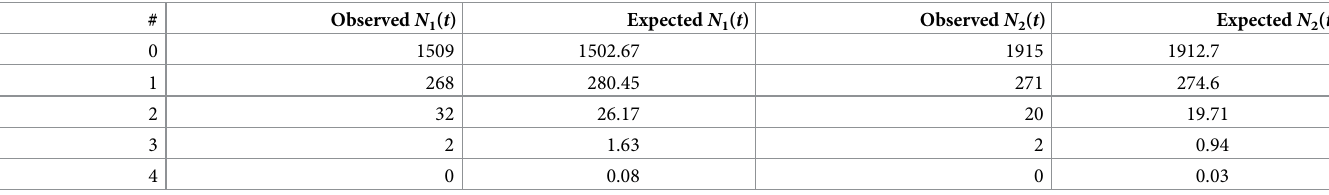
Table 3. IPHs per day in N 1 ( t ) and N 2 ( t ): Frequencies observed and expected from a Poisson